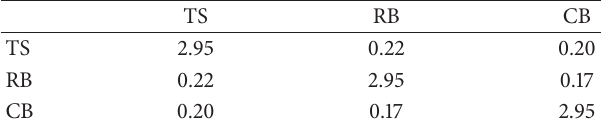
Table 3: Mutual information between different business lines.